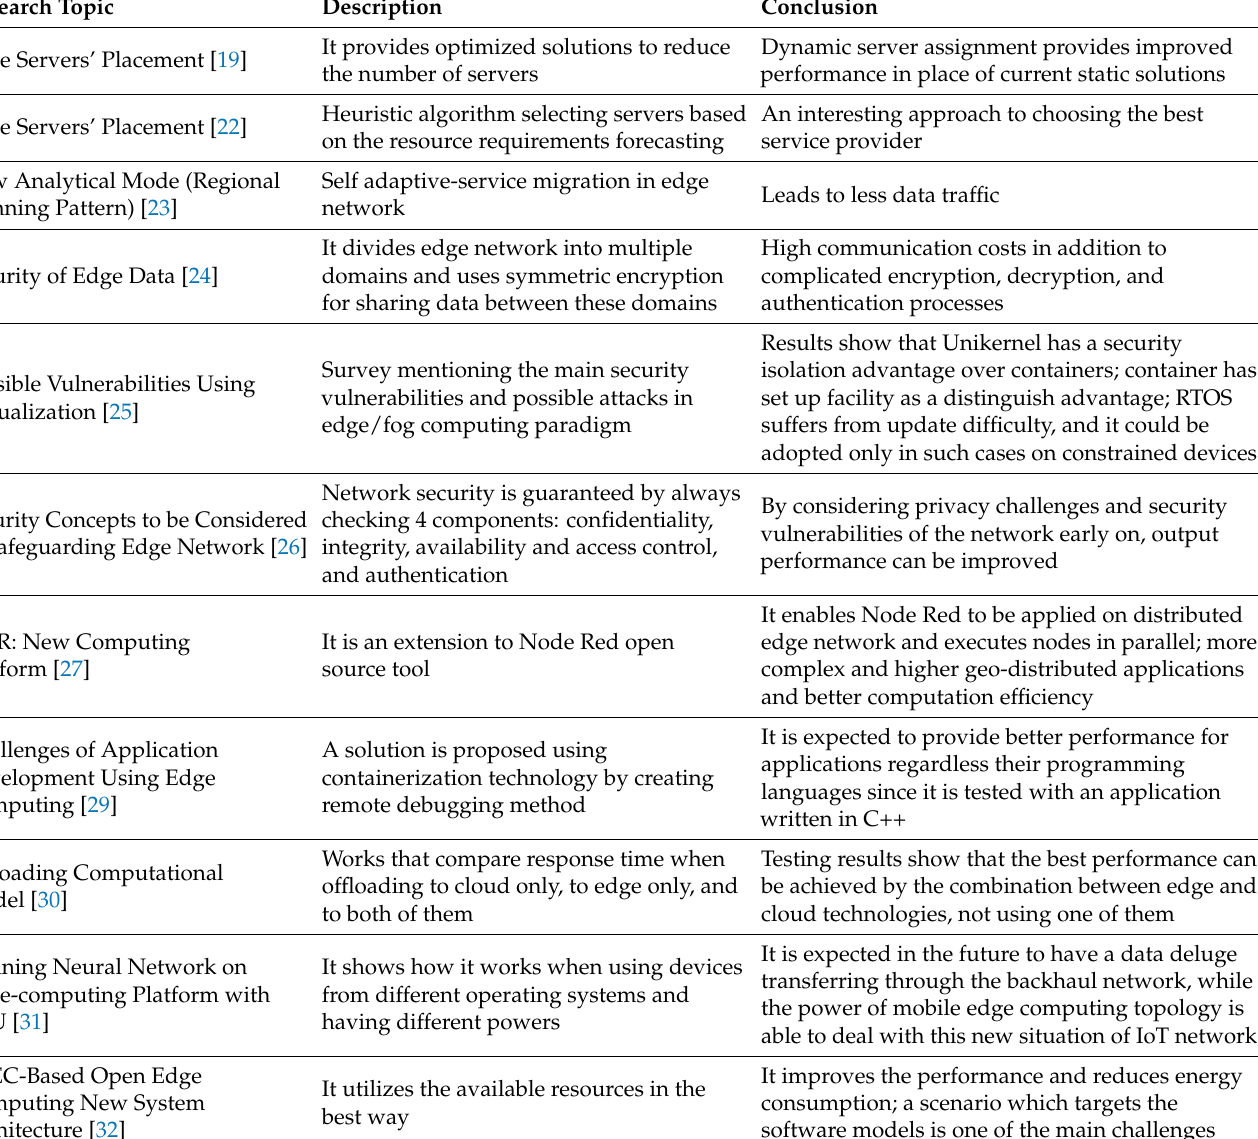
Table 1. Overview of research works cited in Sections